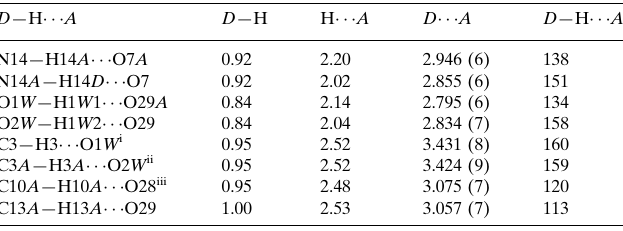
Hydrogen-bond geometry (A˚ , (cid:4)